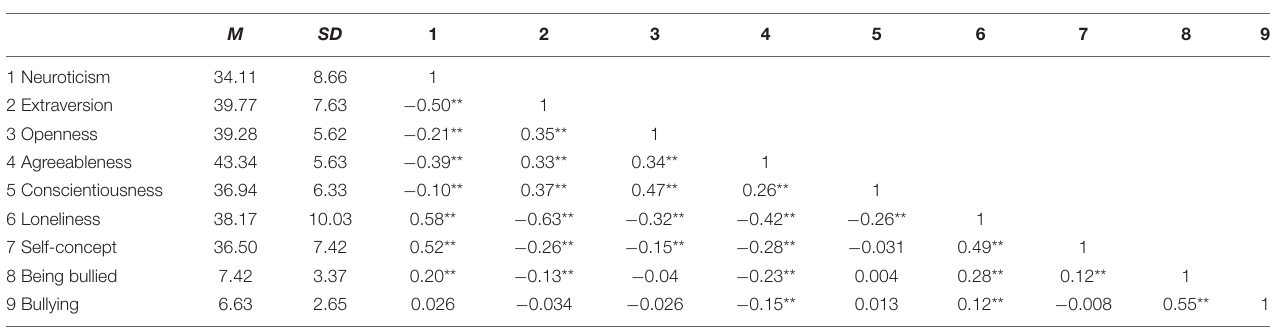
TABLE 1 | Descriptive statistics and correlation coefficients for each variable ( N = 1,631).